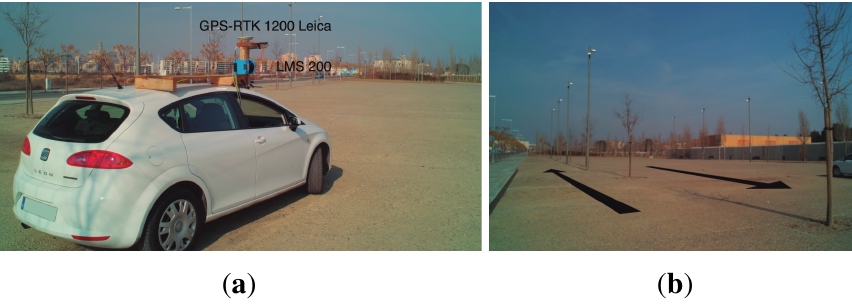
Figure 15. Setup of test: test for checking the perpendicularity of the scanning plane. ( a ) LiDAR mounted on a car; ( b ) test zone showing car paths.